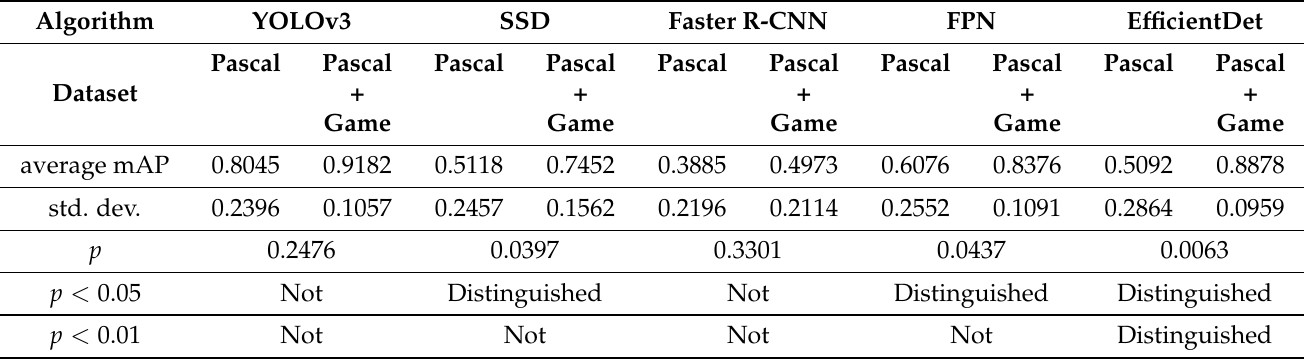
Table 8. p values for the mAPs from five object detection algorithms. We compared the algorithms trained by PascalVOC and retrained by PascalVOC with game scenes. Note that PascalVOC is abbreviated as Pascal in the table.